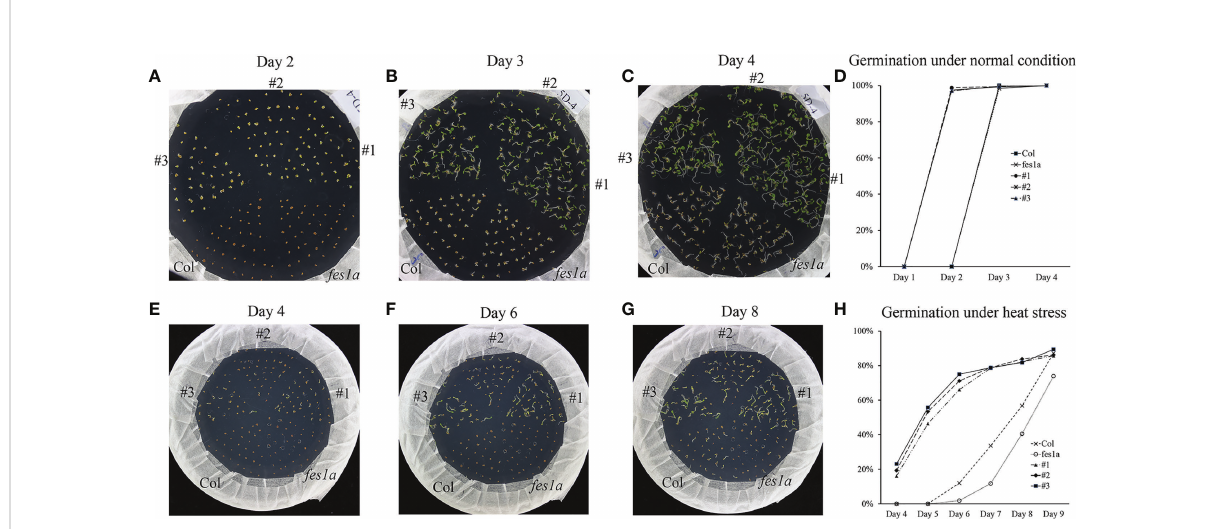
FIGURE 6 The seeds germination of TaFes1A-5D transgenic lines under normal and heat conditions. (A – C) . Dynamic germination of transgenic lines, wild type, and mutant seeds under normal condition (22/19°C, 16/8h). (D) Germination statistics calculated from (A – C) under normal condition. (E – G) . Dynamic germination of transgenic lines, wild type, and mutant seeds under heat stress condition (35/19°C, 16/ 8h). (H) Germination statistics calculated from (E – G) under normal